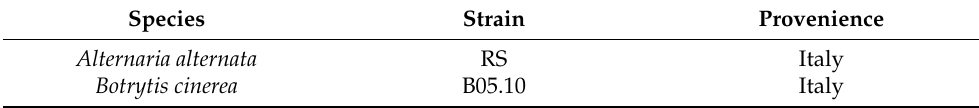
Table 1. List of the phytopathogenic fungi used in this study. Species Strain Provenience Alternaria alternata RS Italy Botrytis cinerea B05.10